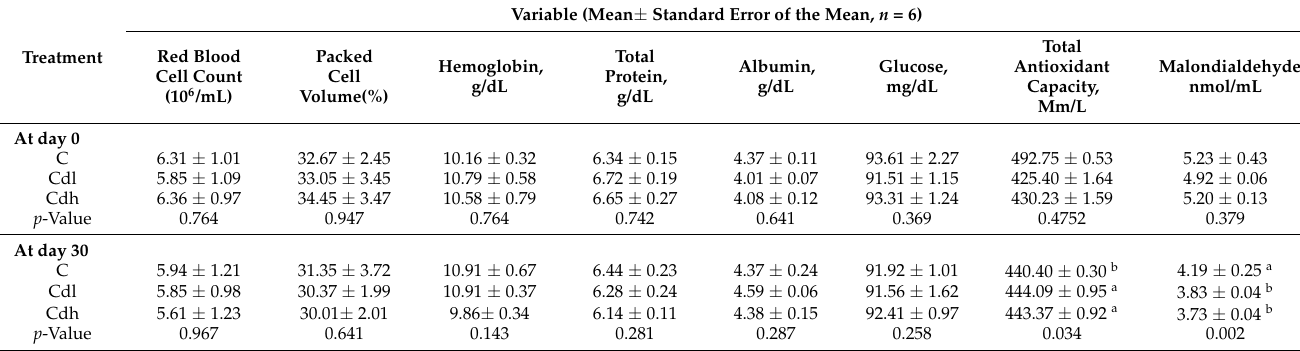
Table 5. Hematological attributes, blood plasma metabolites, and antioxidant activity of rabbits treated with different concentrations of Cleome droserifolia (Forssk.) Del. (Cd) (0: C, Cdl: 1.25 g/kg of DM diet, or Cdh: 2.5 g/kg of DM diet). Variable (Mean ± Standard Error of the Mean, n = 6) Red Blood Treatment Cell